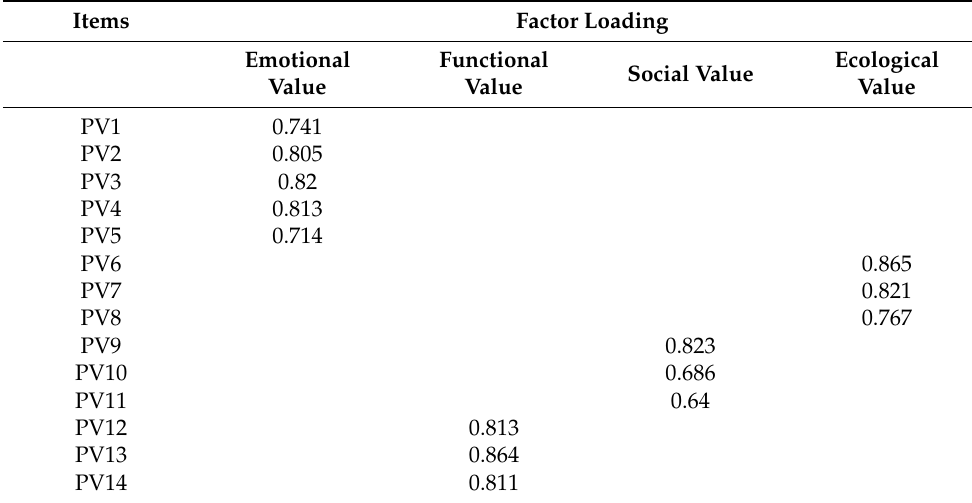
Table 3. Rotating component matrix of perceived value.